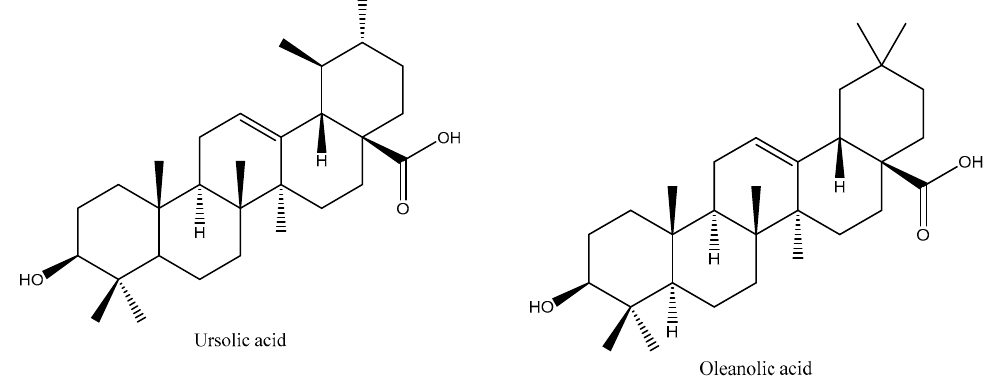
Figure 1. The chemical structure of ursolic acid (UA) and oleanolic acid (OA). Cytotoxicity assays are widely used by the pharmaceutical industry to